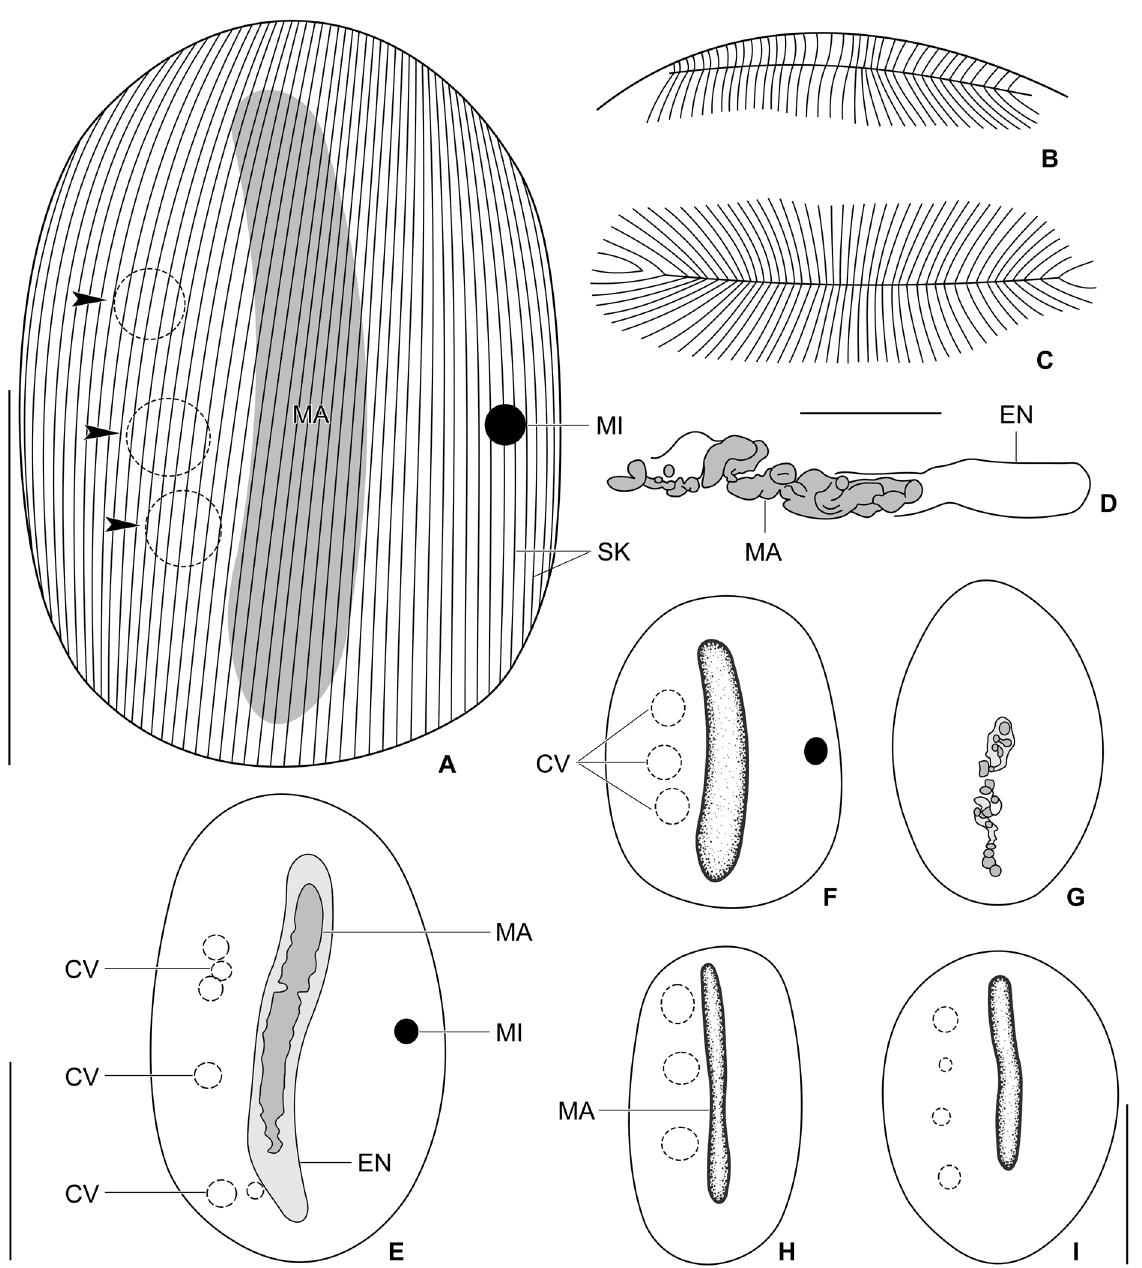
Fig. 8. Anoplophrya lumbrici (Schrank, 1803), Slovak specimens in vivo . A . Semi-schematic diagram of the ventral side, showing the nuclear apparatus, the arrangement of contractile vacuoles (arrowheads) and the somatic ciliary pattern. B–C . Details of the anterior and posterior body pole, showing the apical and the terminal suture. D . In dying cells, the macronucleus diminishes in size leaving behind a conspicuous hyaline envelope. The macronucleus sometimes also fragments within the envelope in postmortem cells. E‒I . Variability of body shape and size as well as of the contractile vacuole and nuclear apparatus. The micronucleus is situated conspicuously far away from the macronucleus, namely, near the middle of the left body margin and always opposite to the row of contractile vacuoles. Drawn to scale. Scale bars: A, E–I = 50 µm; D = 20